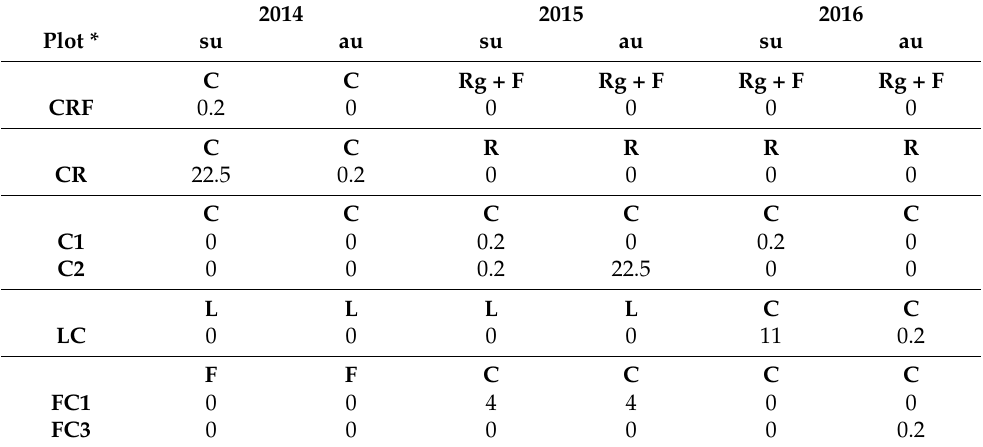
Table 6. Abundance of Echinochloa spp. (%) in the winter cereal fields in summer and autumn and in their previous and subsequent crops. C: cereal, Rg: ryegrass, F: fescue, L: lucerne, R: